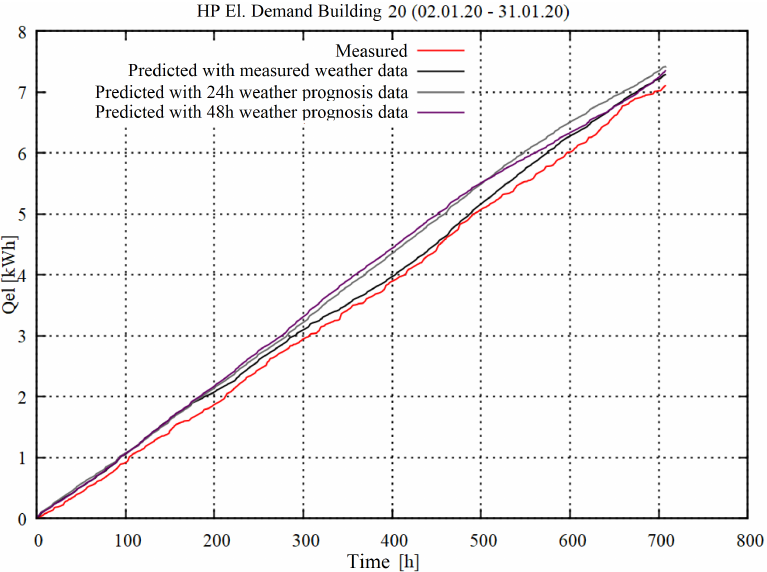
Figure A4. Impact of weather prediction inaccuracy on cumulative electrical heat pump energy